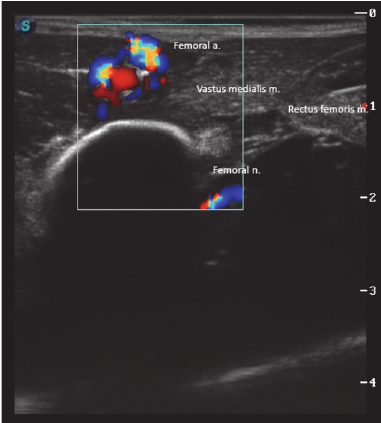
Figure 2: Femoral nerve: ultrasonographic view of the inguinal area of a wallaby ( Macropus rufogriseus ). The transducer was positioned on a transverse plane with respect to the long axis of the femur to obtain a short axis view of the femoral nerve. The femoral nerve can be identified as a hyperechoic rounded structure cranial to the femur, caudal to the rectus femoris muscle, and deep to the femoral artery and vastus medialis muscle. S is